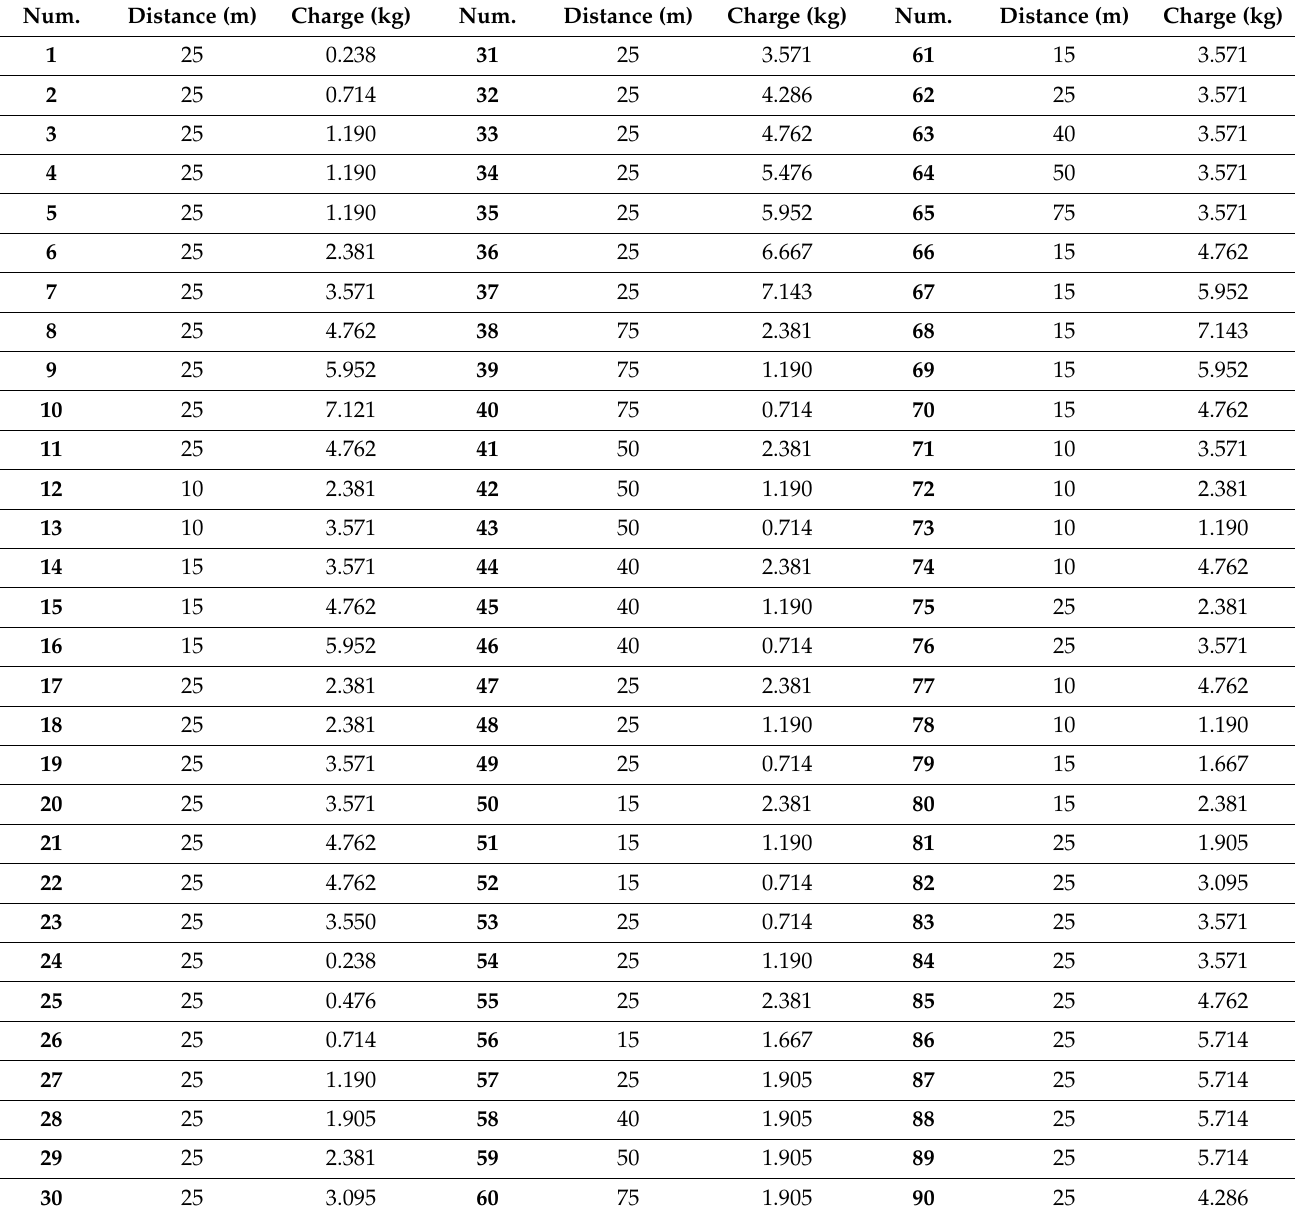
Table 4. Riodin charge and distance for each